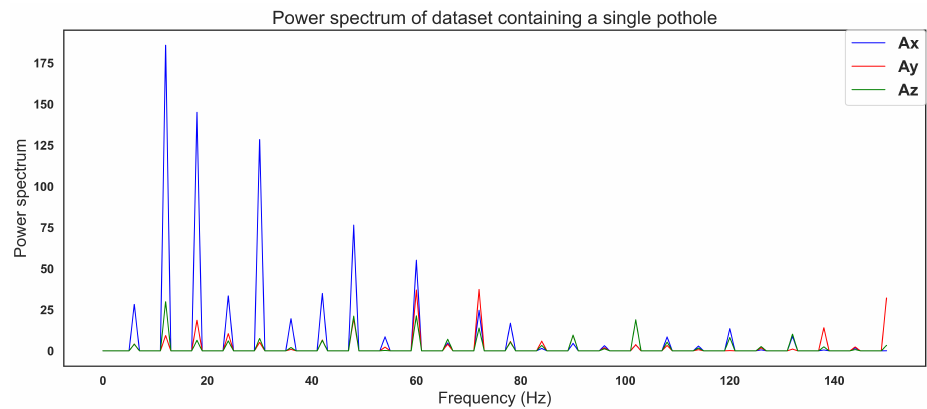
Figure 9. Power spectrum of a pothole.